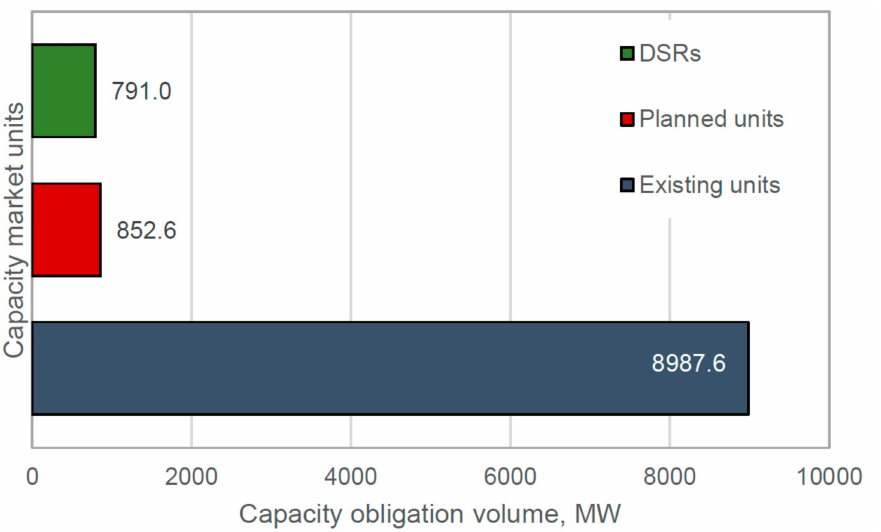
Figure 8. Capacity obligation volume contracted in main capacity auction for 2023 delivery year– break down by official (declared) assignments to capacity market units. Source: Own analysis based on [39].